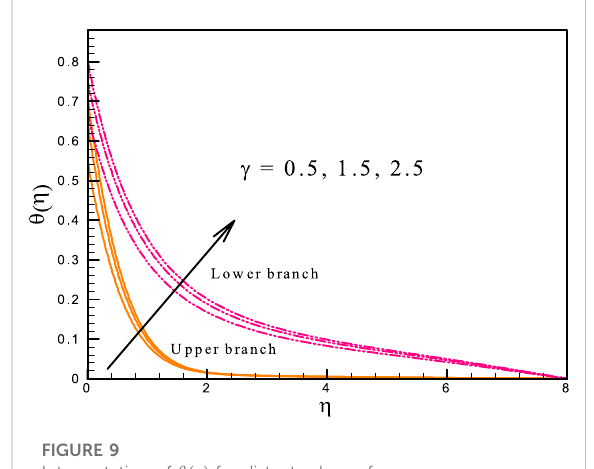
FIGURE 11 Interpretation of θ ( η ) for distant values of θ w